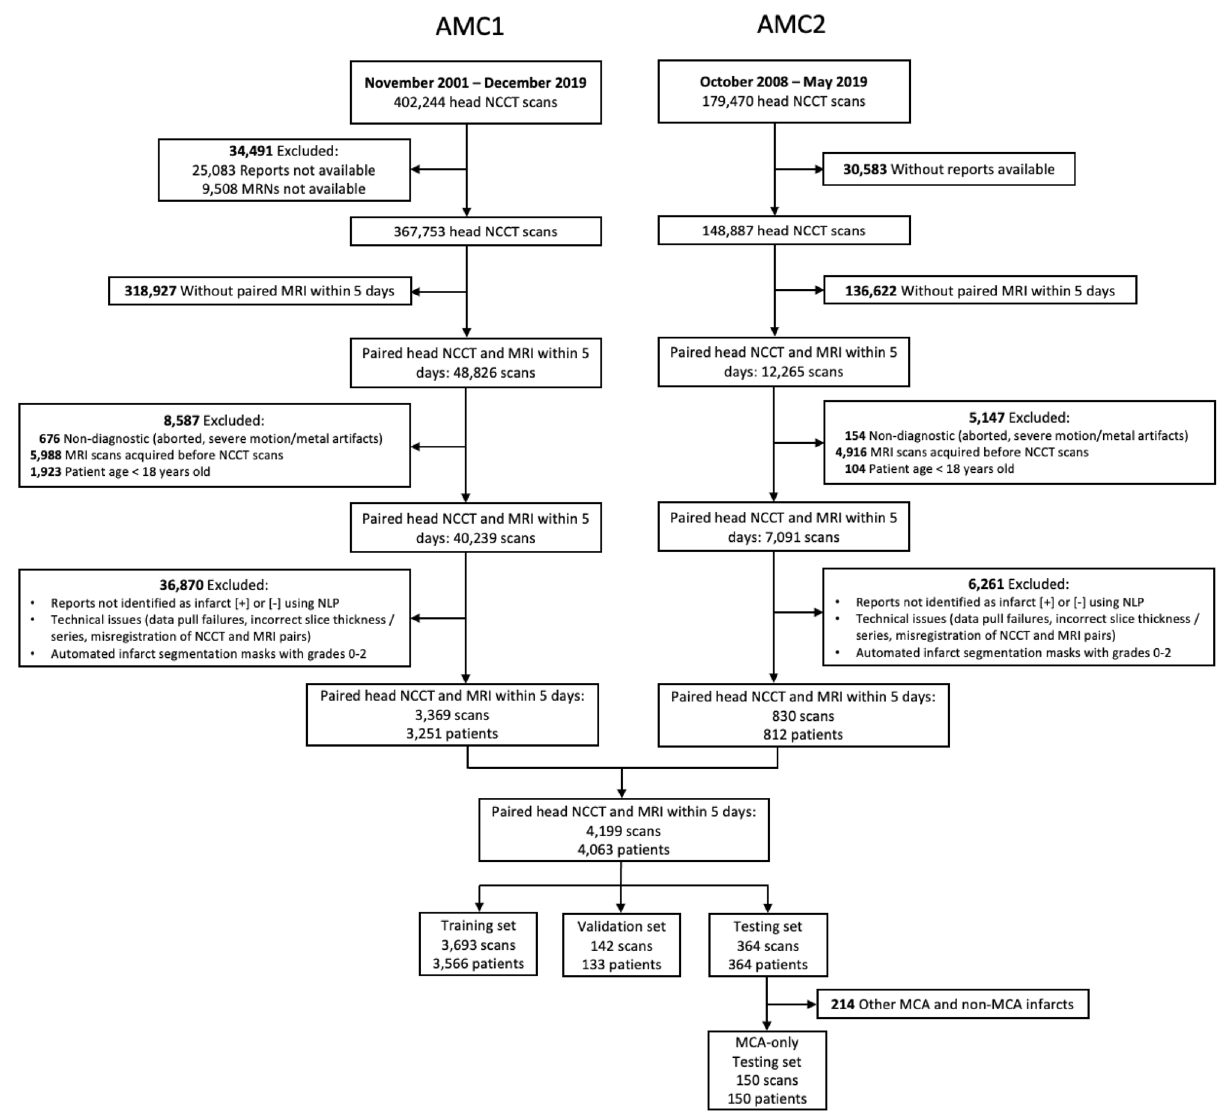
Figure 4. Flowchart of patient inclusion from two academic medical centers. (Legend: AMC = academic medical center, NCCT = non-contrast head CT, MRN = medical record number, NLP = natural language processing, MCA = middle cerebral